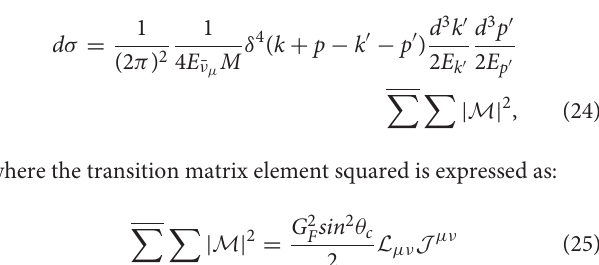
e L , e P , and e T represent ˆ ˆ ˆ